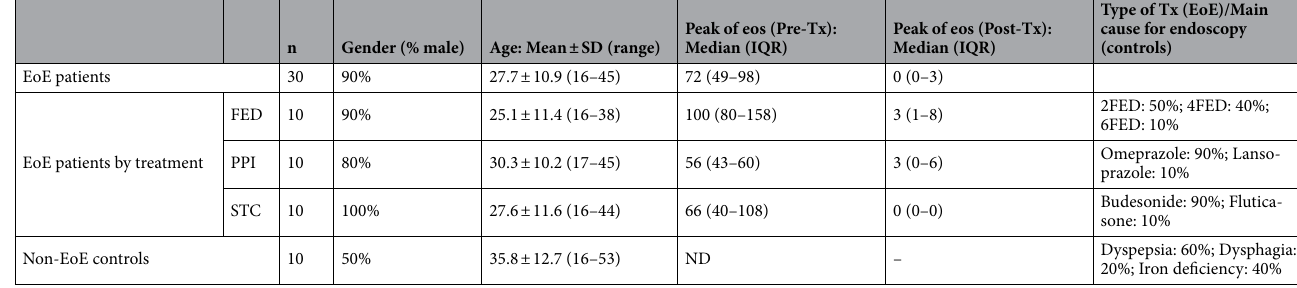
Table 1. Demographic and clinical characteristics of the subjects included in the study. EoE: eosinophilic oesophagitis; eos: eosinophils; n: number of subjects; Tx: treatment; IQR: interquartile range; FED: food- elimination diet; PPI: proton pump inhibitors; STC: swallowed topical corticosteroids; ND: not determined (2 controls had no detectable eosinophils, 8 controls had no histological alterations in the oesophageal